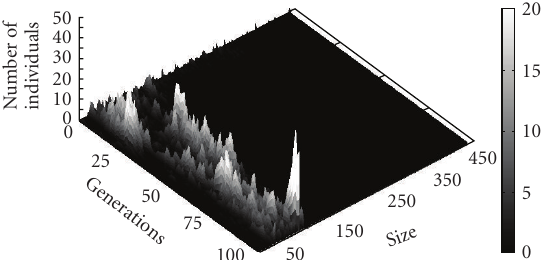
Figure 7: Symbolic regression Experiment 2: chromosome size in the population.